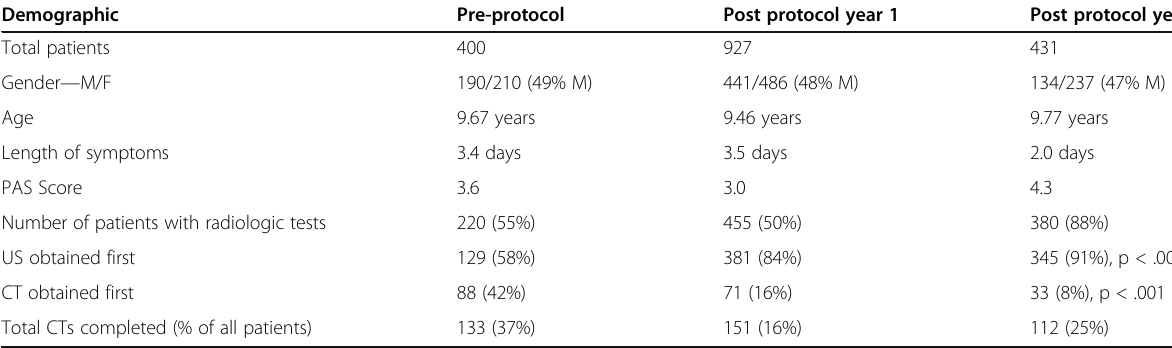
Table 2 Demographics and radiologic